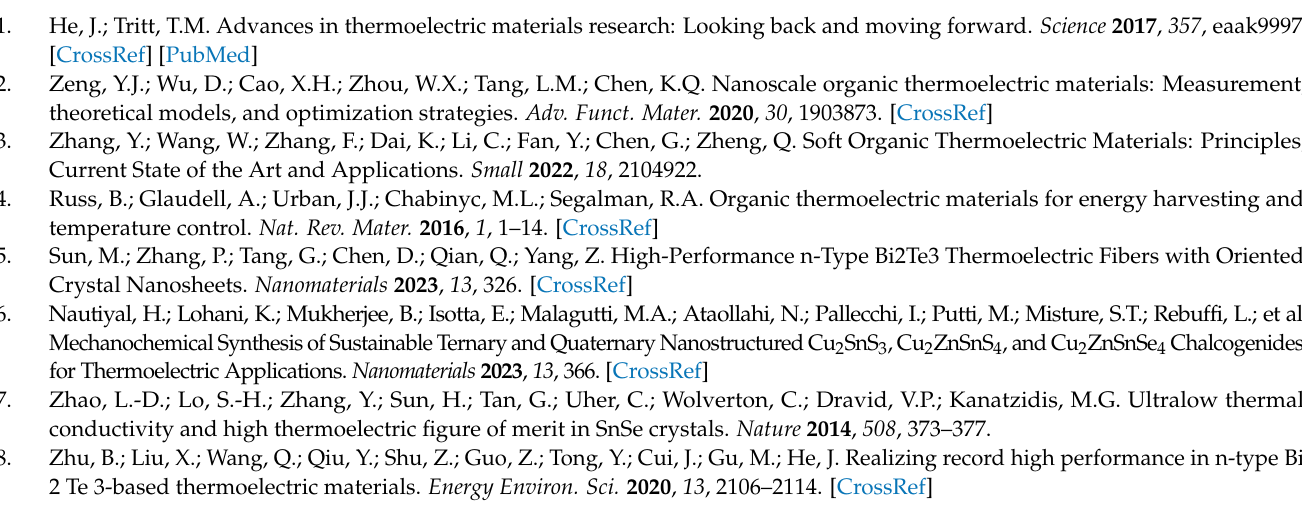
H NMR of compound 2 ; Figure S3: 1 H NMR of compound 3 ; Figure S4: 1 H NMR of compound Tz ; Figure S5: 1 H NMR of compound TTz ; Figure S6: 1 H NMR of PDTz; Figure S7: 1 H NMR of PDTTz; Figure S8: GPC spectrum of PDTz; Figure S9: GPC spectrum of PDTTz; Figure S10: DFT-calculated stretching modes of the PDTz tetramer. The wavenumbers in parentheses indicate experimental values; Figure S11: DFT-calculated stretching modes of the PDTTz tetramer. The wavenumbers in parentheses indicate experimental values; Table S1: d-spacing of (100) and (010) peaks in Figure